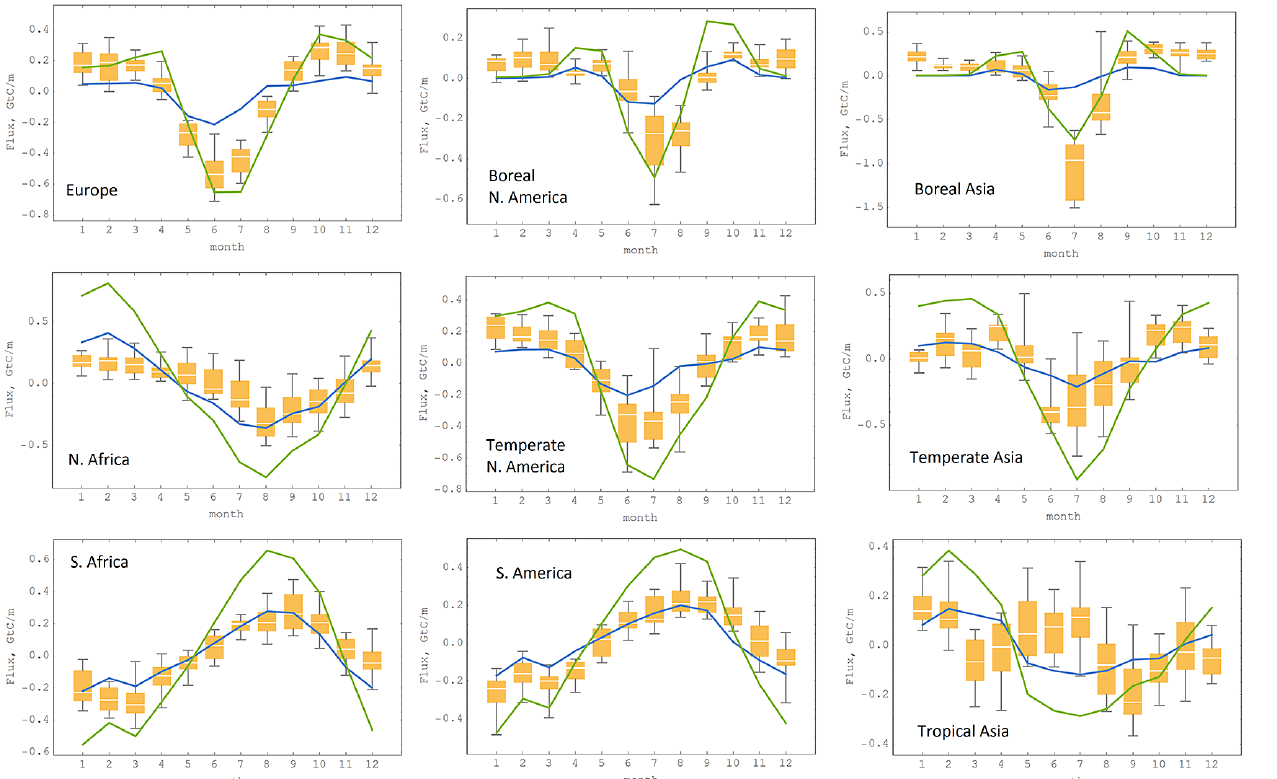
Figure 7. The seasonal cycle of the regional N a,mod for WUE = 2.7gCL − 1 , Q 10 = 1.4, and φ = 0.2 (green) as compared to that for WUE = 1.8gCL − 1 , Q 10 = 2.0, and φ = 0 (blue), and to the detrended TransCom 3 seasonal CO 2 flux (orange) estimated from atmospheric inversions (Gurney and Denning,